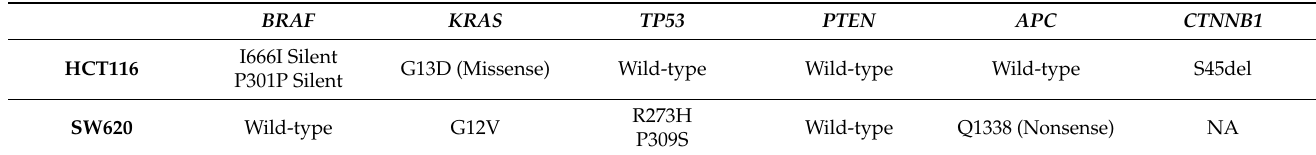
Table 1. Mutational status of relevant oncogenes and tumor suppressor genes. HCT116 cell line was isolated from the large intestine of colorectal cancer-affected adult male; SW620 cell line was derived from the lymph node metastatic site of colorectal cancer of a 51-year-old Caucasian